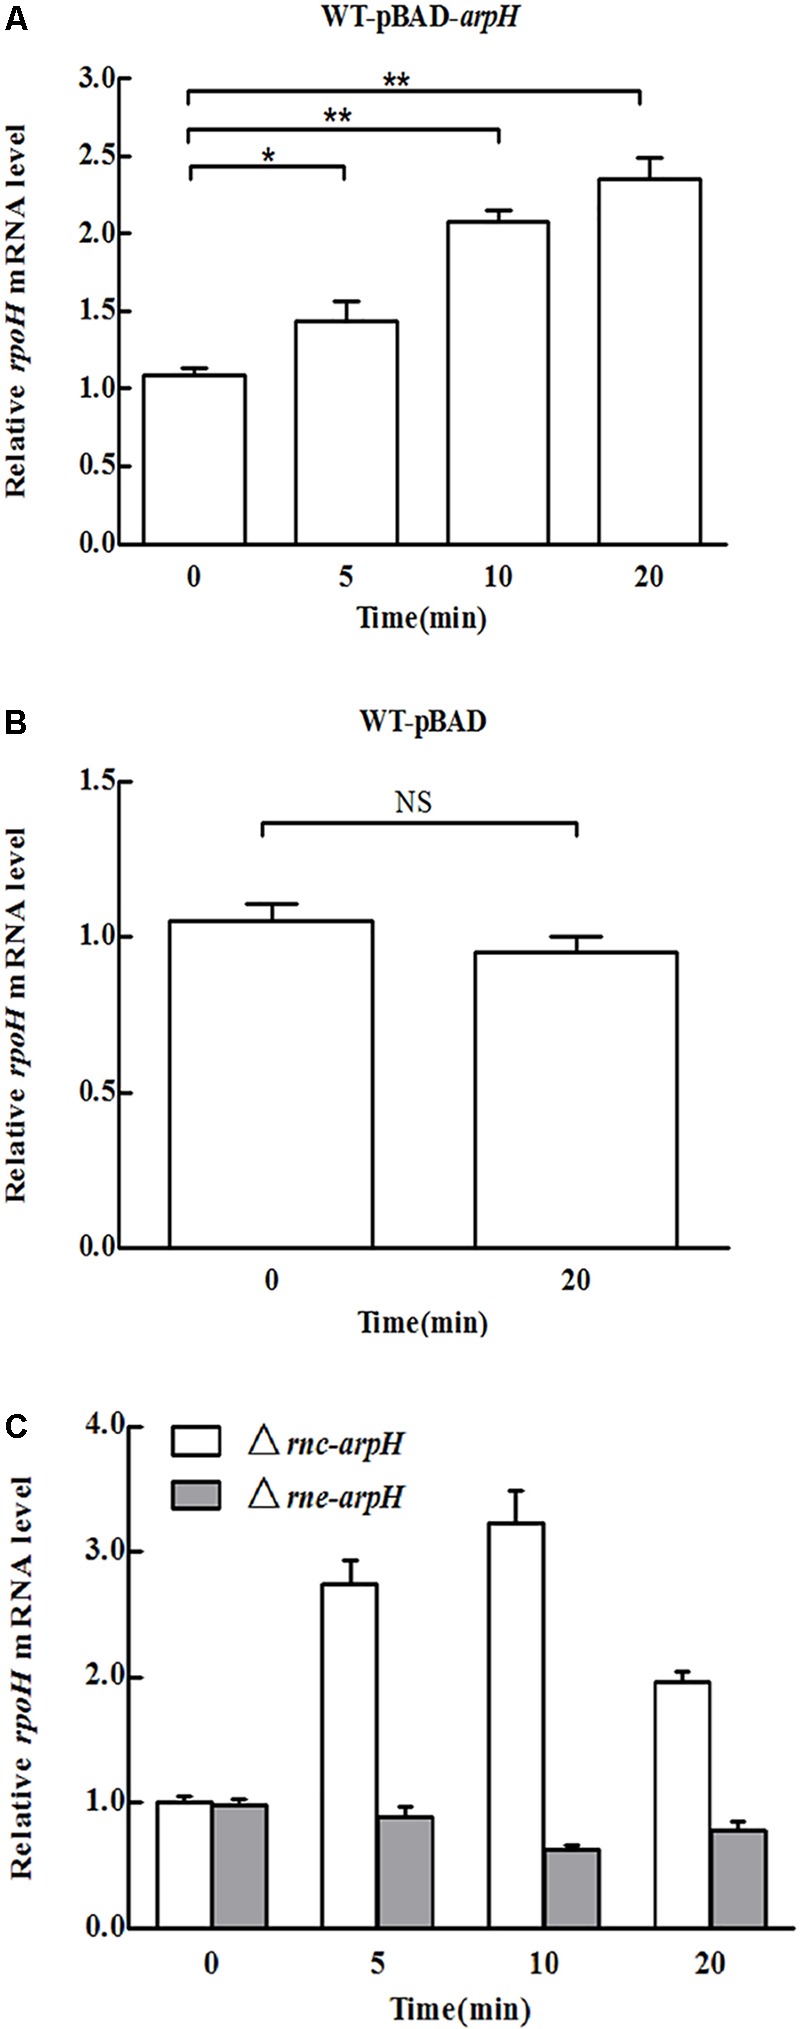
Overexpression of ArpH. mRNA levels of rpoH in (A) WT-pBAD-arpH, (B) WT-pBAD, and (C) Δrnc-arpH and Δrne-arpH strains were measured using qRT-PCR. Total RNA was harvested from strains grown to an OD600 of 0.4 after 0, 5, 10, or 20 min of induction with 0.2% L-arabinose. ∗P < 0.05, ∗∗P < 0.01. NS, not statistically significant.